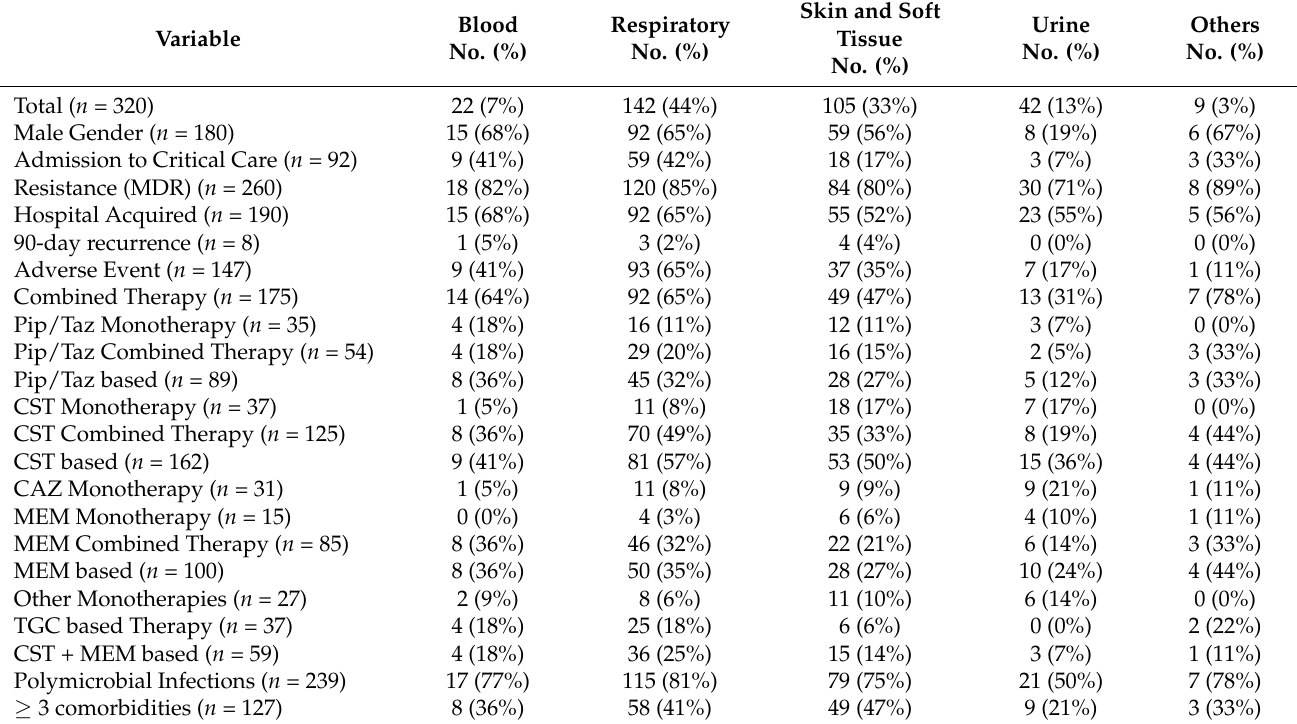
Table 2. Patients’